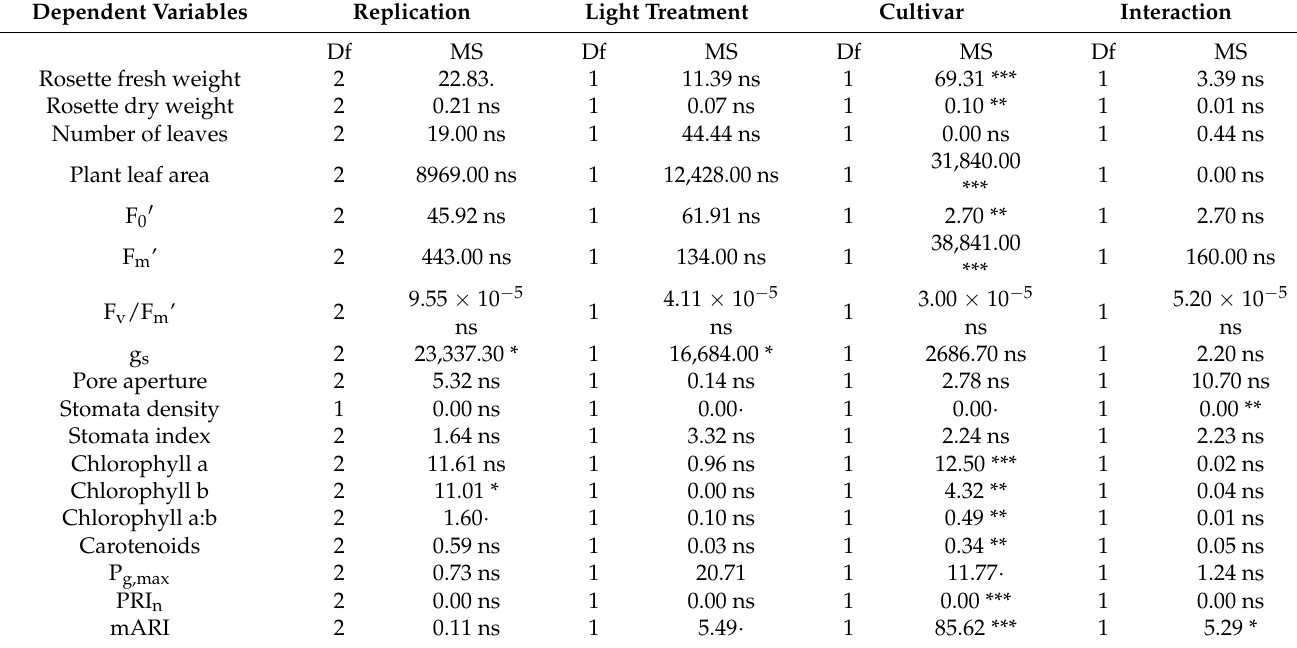
Table 2. ANOVA results based on split plot analysis with light treatment as the whole plot factor, cultivar as subplot factor, and replications as block. Effects of lettuce cultivar (cv. ’Aquino’, RZ, CVg and cv. ‘Barlach’, RZ, CVr) exposed to 15 days of light spectral treatment (blue-enriched white light, WB, and white light, WW) and their interactions on the measured dependent variables: biomass, morphological traits, light-adapted chlorophyll a fluorescence (F 0 (cid:48) , F m ’, F v /F m ’), stomatal conductance (g s ), stomatal pore aperture, stomatal density, stomatal index, chlorophylls, carotenoids, maximal gross (P g,max ) photosynthetic rate, photochemical reflectance index (PRI n ), and modified anthocyanin reflectance index (mARI).